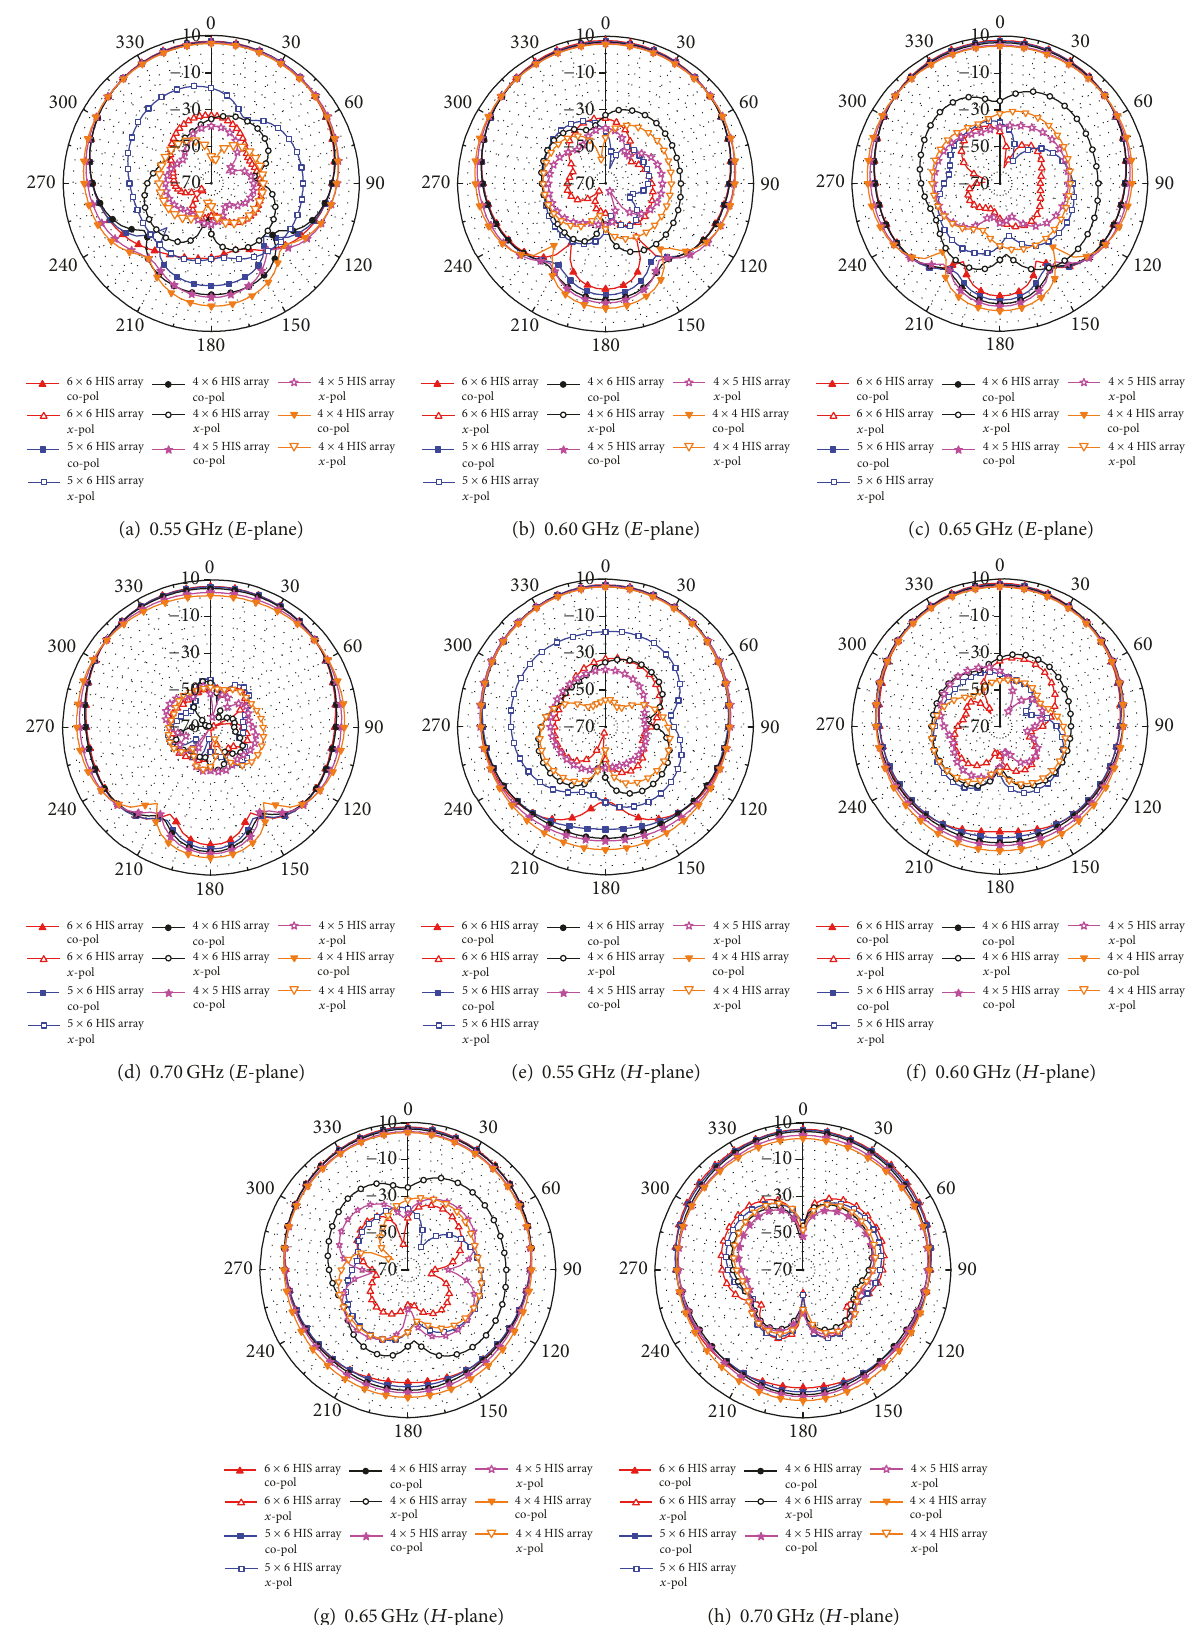
Figure 7: Effect of HIS array size to the radiation patterns on 𝐸 ( 𝑧 - 𝑥 ) and 𝐻 ( 𝑧 - 𝑦 ) planes at four frequency points: 0.55 GHz, 0.60 GHz, 0.65 GHz, and 0.70